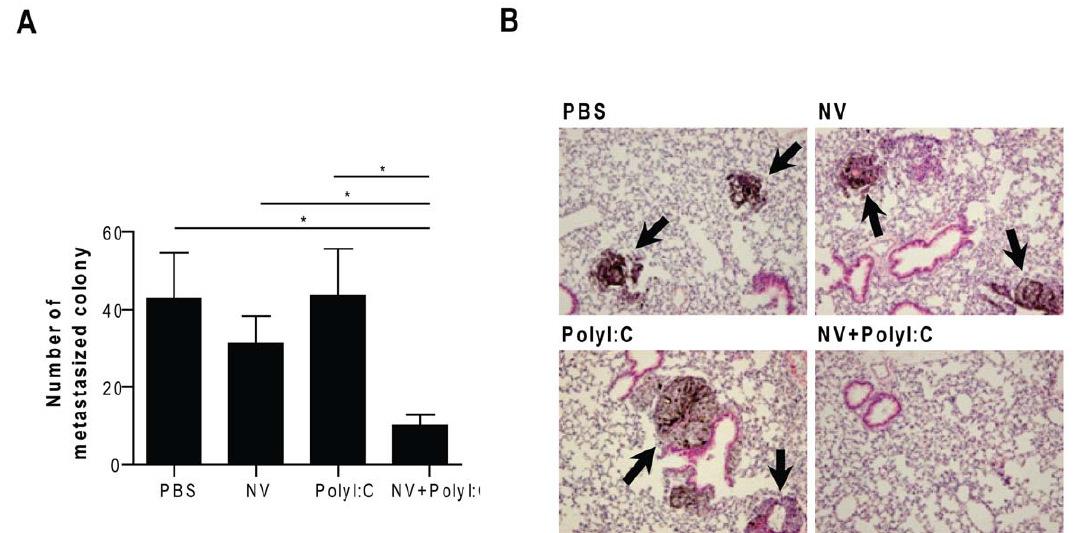
Figure 4. Effect on metastatic tumor growth of therapeutic vaccination with tumor-derived NVs. Mice (n=5 per group) that were pre- injected intravenously with B16BL6 melanoma cells were administered 10 m g of NVs with or without 50 m g of polyI:C per mouse. A. The B16 melanoma pulmonary metastases in the different treatment groups were counted. The data shown are from two independent experiments. * P , 0.05. B. Histologic sections of representative lung metastases. Arrows indicate the B16 melanoma mass in the lung. Mice immunized with NVs plus polyI:C showed decreases in the number and size of metastasized melanomas. Original magnification 6 200; H&E staining.